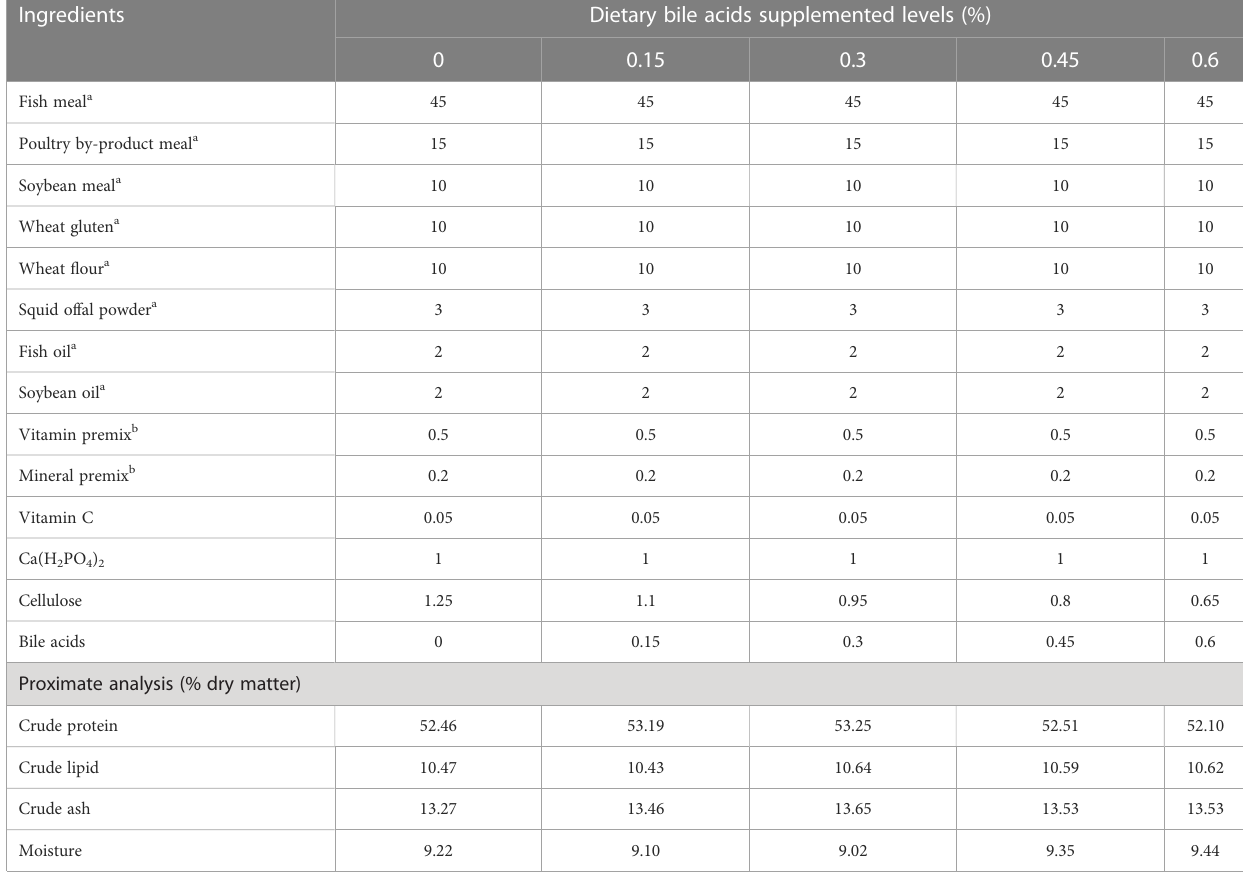
TABLE 1 Formulation and proximate compositions of the experimental diets.